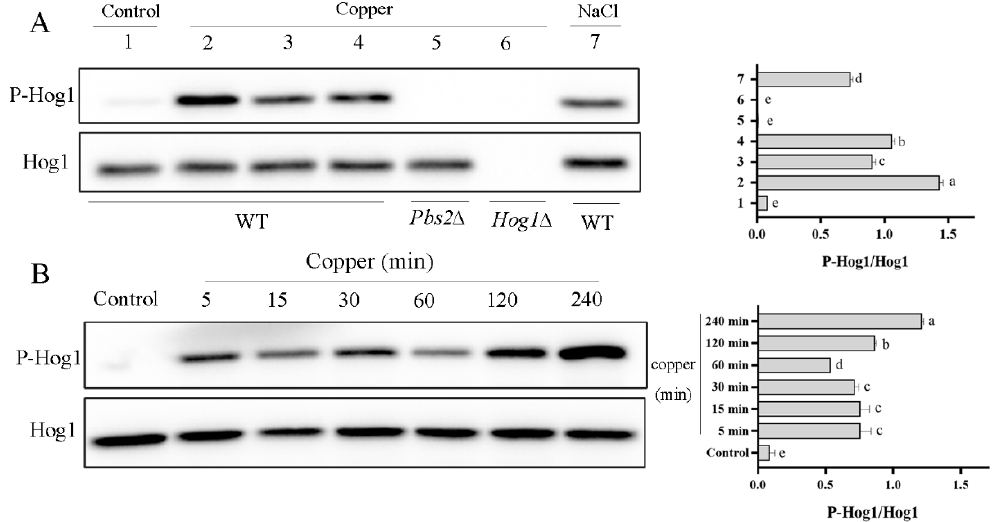
Figure 3. The Activation of Hog 1 induced by copper treatment: ( A ) copper significantly triggered Hog1 phosphorylation; the exponential growing cultures (OD600 = 0.8) were untreated (lane 1) or treated with 4 mM CuSO 4 for a short time (lanes 2, 3, and 4). Western blotting analysis was performed with protein extracts. Following electrophoresis on a 10% polyacrylamide denaturing gel (30 μ g per lane) with subsequent electrotransfer, the blot was probed with anti ‐ Hog1 antibody and anti ‐ phospho ‐ p38 antibody. The wild type cell was treated with 0.4 M NaCl for 5 min, and extracts were analyzed as a positive control (lane 7). Pbs2 ∆ and Hog1 ∆ mutant strains were also treated with 4 mM CuSO 4 for 5 min and extracts were analyzed as negative controls (lane 5 and lane 6) (P ‐ Hog1, phosphorylated Hog1). ( B ) Hog1 exhibited long ‐ lasting phosphorylation under copper exposure. Exponential cells were treated with 4 mM CuSO 4 for different times (5–240 min). Letters a, b, c, d, and e represent significant difference ( p < 0.05) between the treatments.